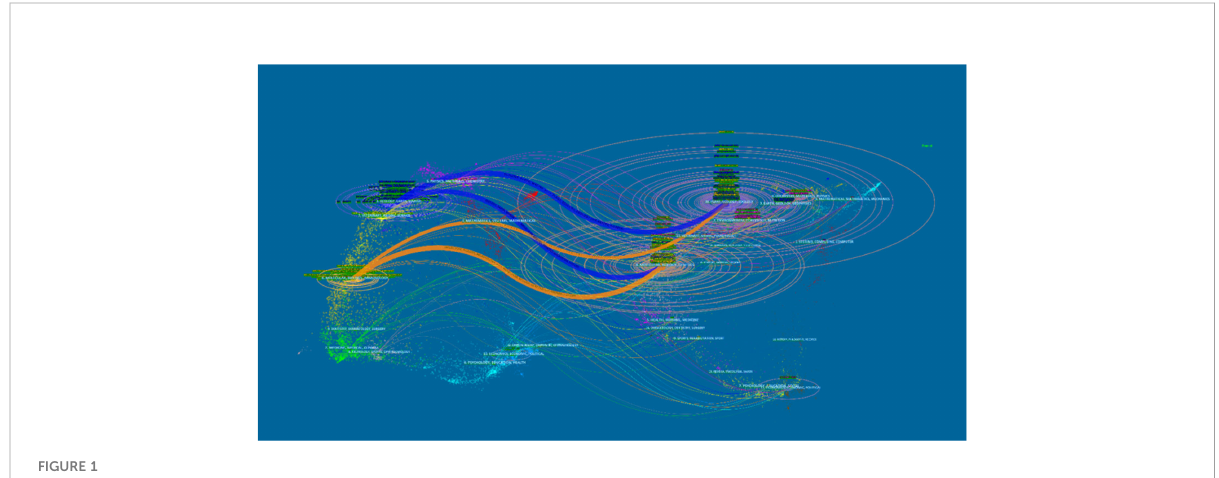
FIGURE 1 Dual-map overlay for lobster research in the